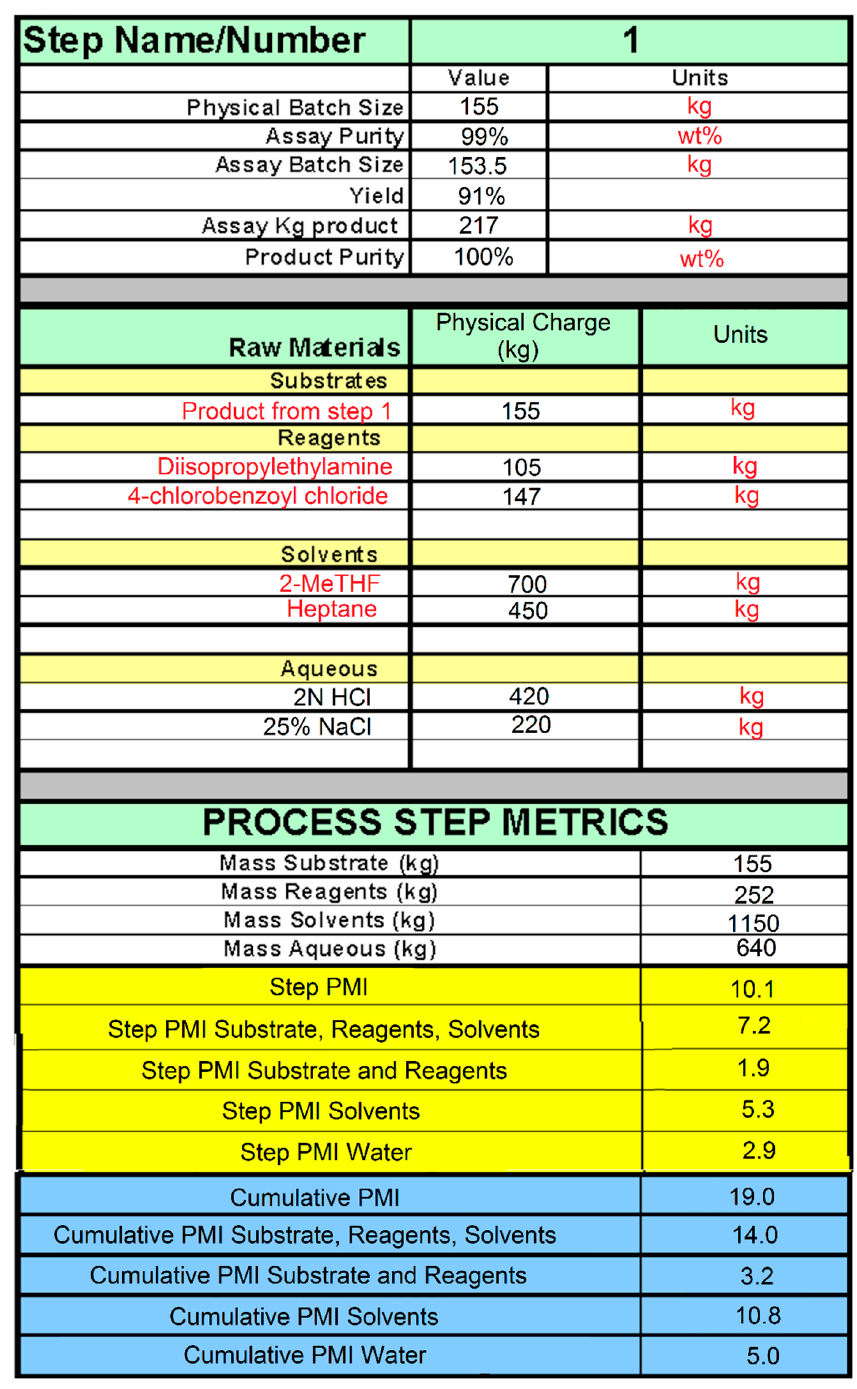
Figure 7. The Roundtable PMI-spreadsheet calculator tool. Adapted from Ref. [53].